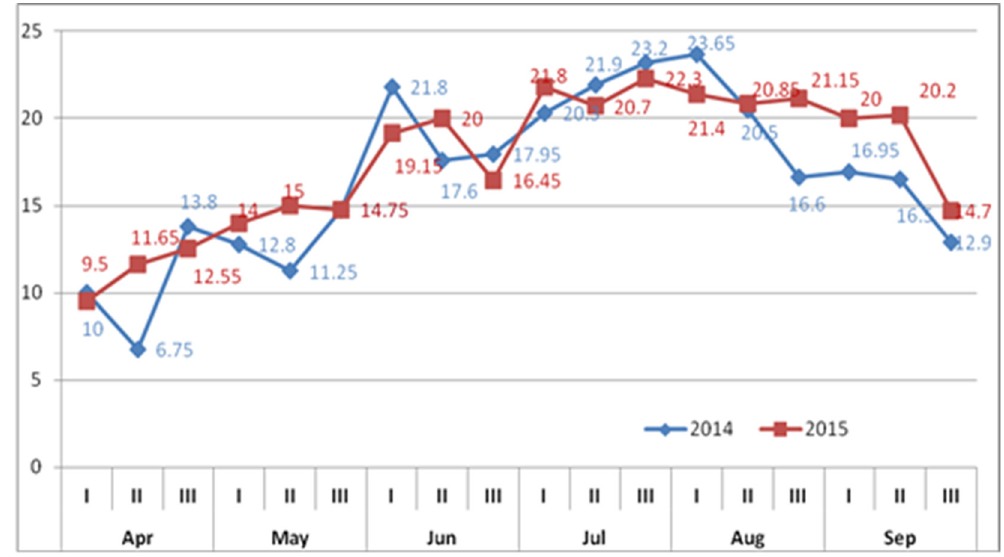
Figure 2. Temperature (°C) during the growing period for the experiment in 2014–2015.